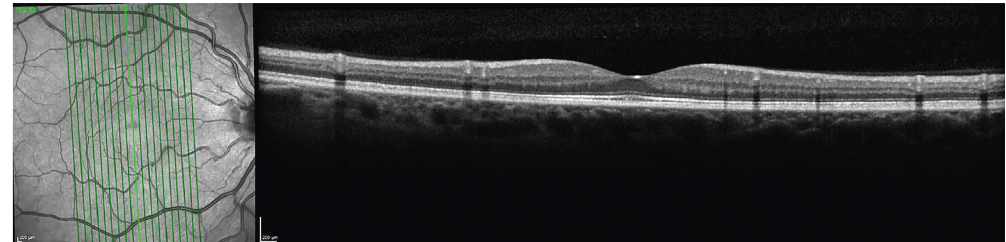
Figure 1: Sample Spectralis OCT posterior pole vertical-oriented scan lines (PPoleV scan) protocols.